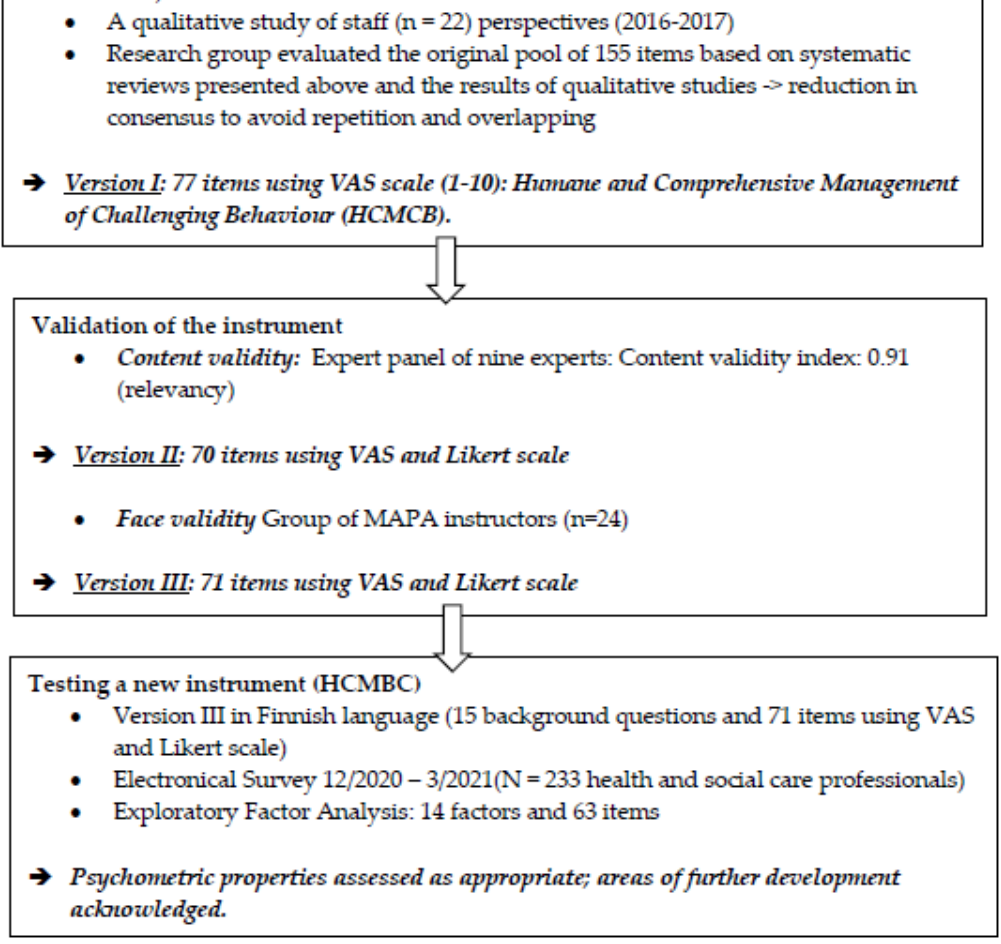
Figure 1. Phases in the development of the HCMCB instrument. [10,12,25,26]